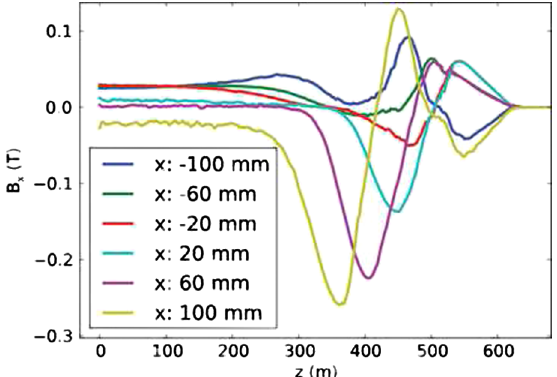
FIG. 48. Stray horizontal magnetic field at a vertical position of (cid:1) 43 mm . The field is shown for a horizontal position from (cid:1) 100 to 100 mm in 40 mm steps